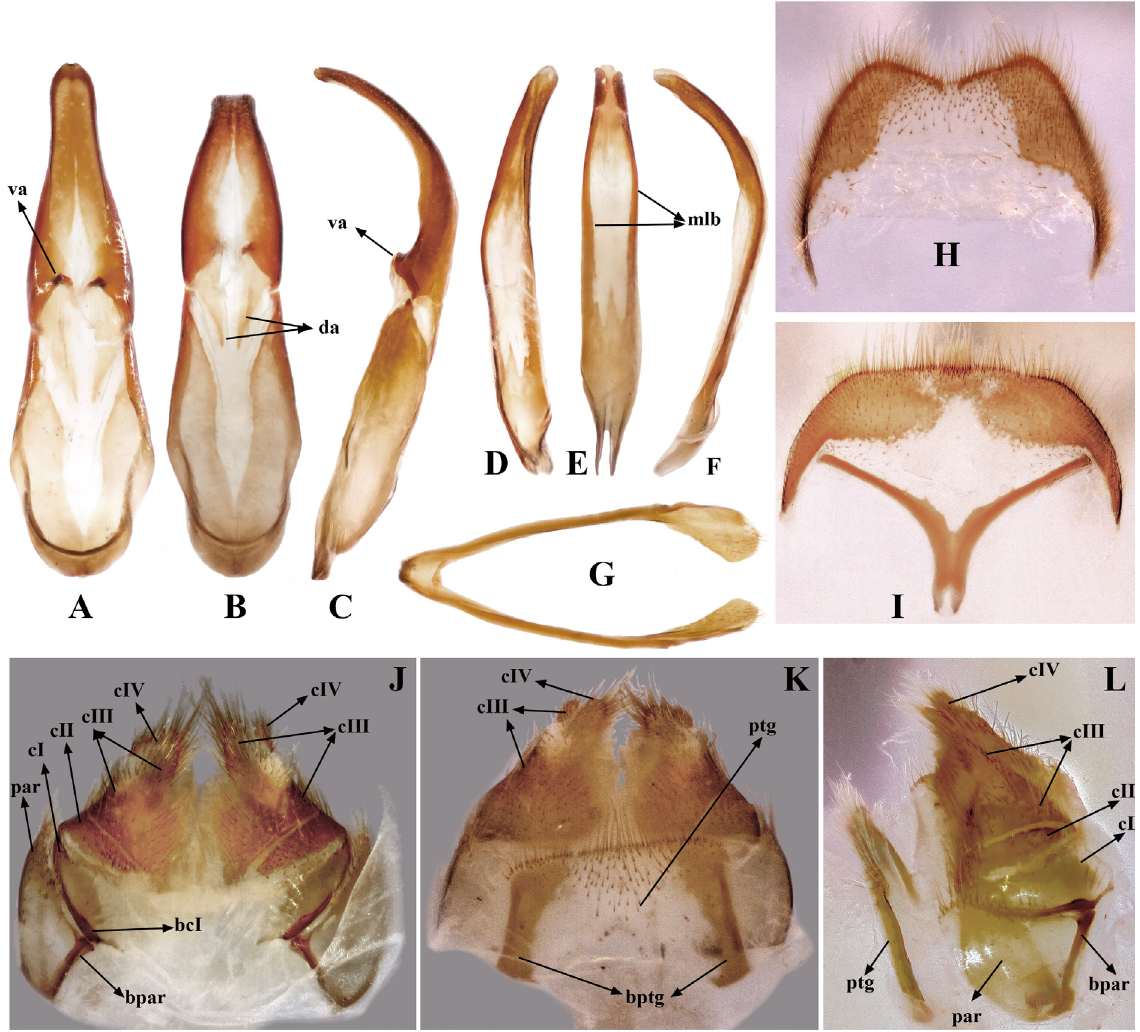
Fig. 14. Apatopsis grombczewskii Semenov, 1891 (ZIN), genitalia. A . Tegmen of aedeagus, ventrally. B . Ditto, dorsally. C . Ditto, laterally. D . Median lobe, ventrally. E . Ditto, dorsally. F . Ditto, laterally. G . Spiculum gastrale. H . ♂, inner sternite VIII. I . ♀, inner sternite VIII and spiculum ventrale. J . Ovipositor, ventrally. K . Ditto, dorsally. L . Ditto, laterally. Abbreviations: see Material and